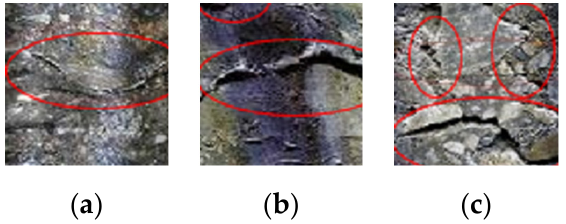
Figure 3. Sample images of dam cracks. ( a ) shows the image where the crack is not obvious. ( b ) shows the image where the crack is obvious. ( c ) shows the image with multiple cracks.